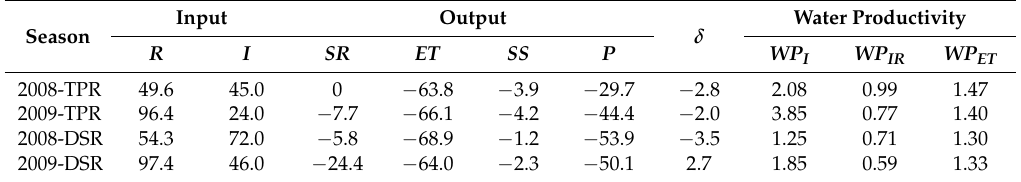
Table 3. Simulated (using Hydrus-1D) components of water balance (cm) in the upper 60 cm of the soil profile, and water productivities ( WP ) (kg · m − 3 ) for the transplanted rice crop in the Taihu Lake Basin. Input Output Season